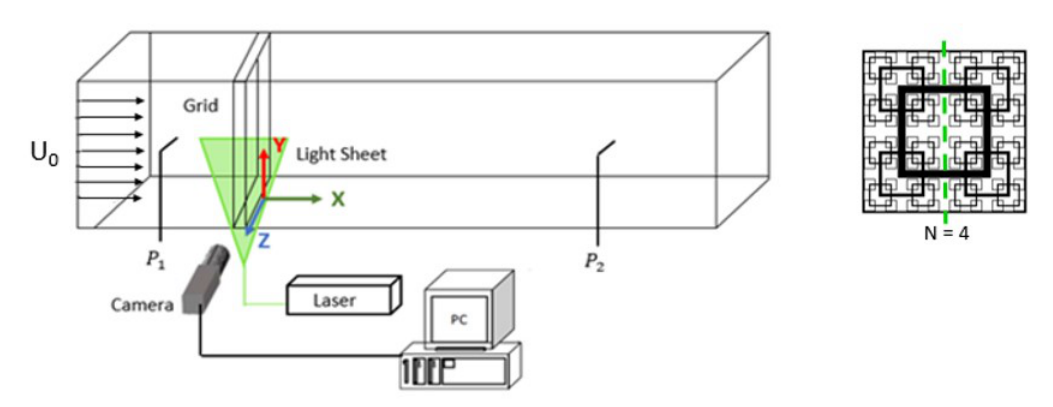
Figure 2. Experimental setup and the location of PIV laser light sheet on the tested fractal